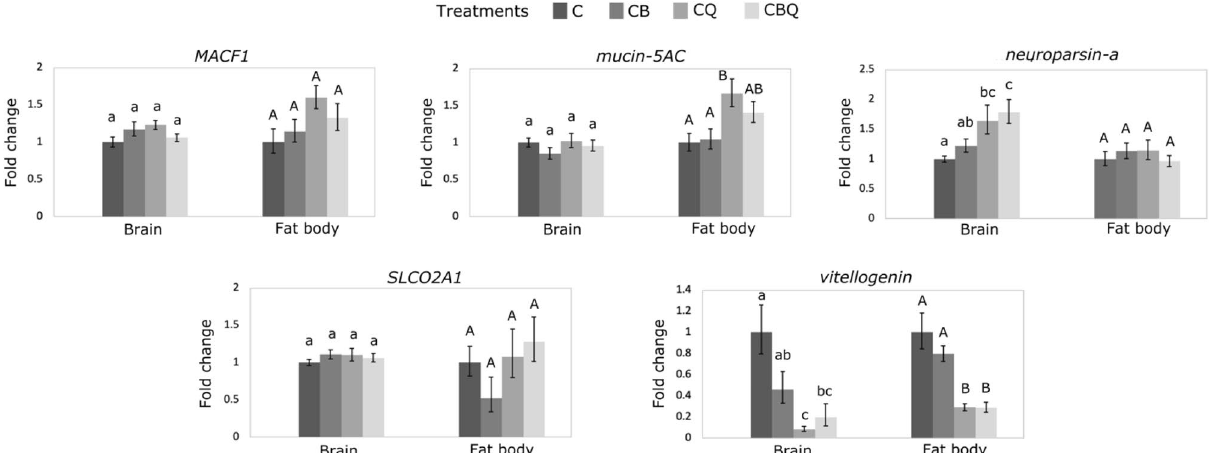
Figure 5. RT-qPCR analysis of selected genes in Bombus impatiens workers’ brain and fat body in the presence of the queen and the brood. Expression levels of selected genes from RNA-seq analysis were examined in workers’ brain and fat body tissues. Pair of newly emerged workers were assigned to four treatments and kept for three days with the queen (CQ), young brood (CB), the queen and young brood (CBQ), or alone (C). Different letters above columns indicate statistical differences at α = 0.05. Data are presented as means ±